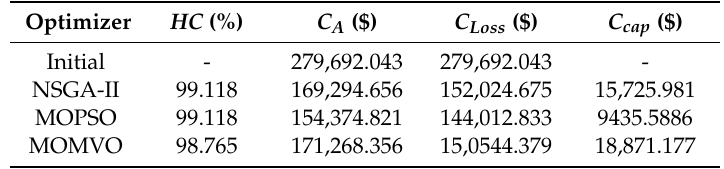
Table 5. Deterministic hosting capacity (HC) results for 83-node distribution system.